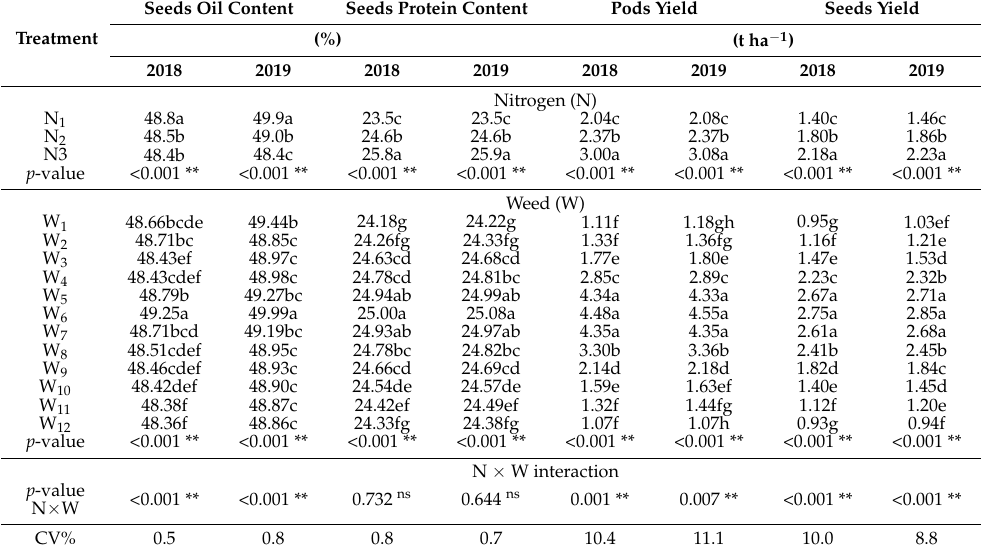
Table 7. Effect of nitrogen fertilization levels (N) and time (early and late) weed removal (W) on Scheme 2018 and 2019 seasons.